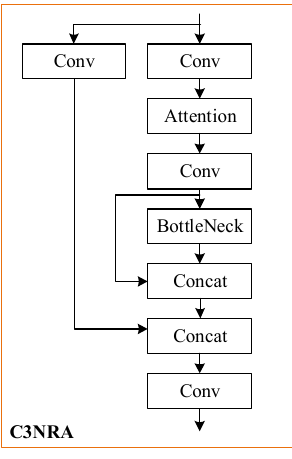
Figure 6. The structure of C3NRA.